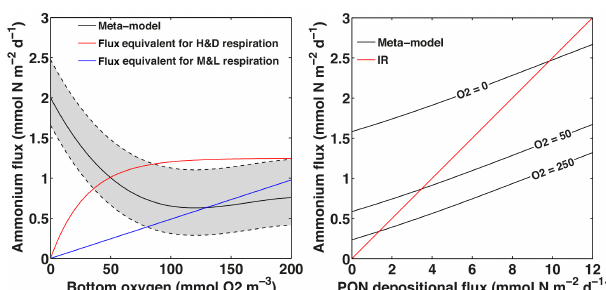
Figure 9. Temporal variability of parameterized O 2 , NH + sediment.